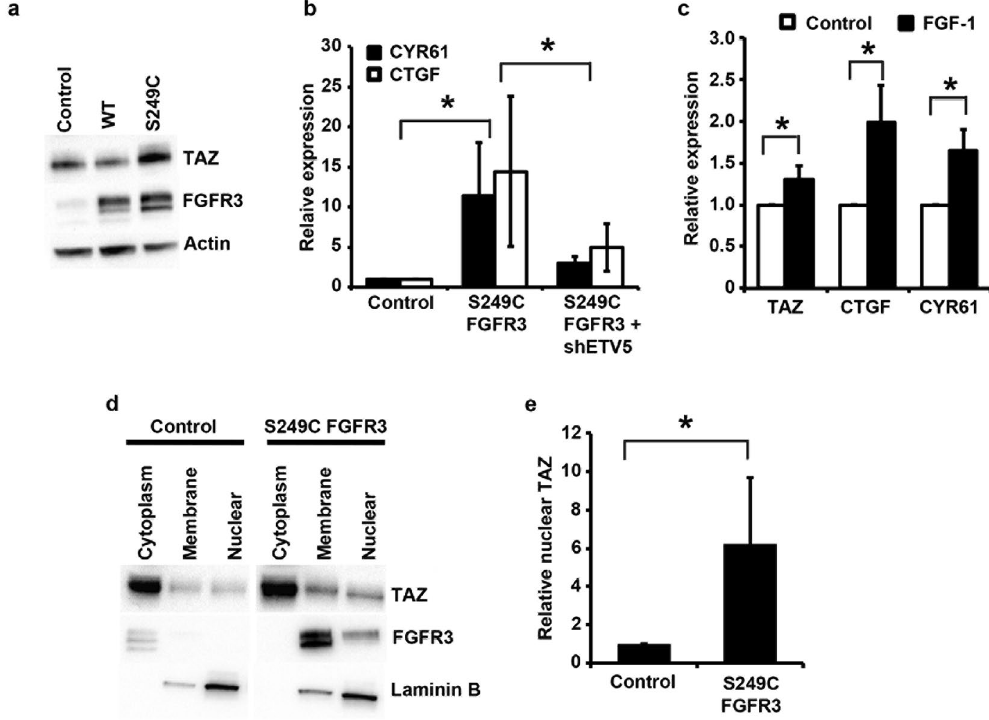
Figure 5. TAZ activity is altered in urothelial cells after FGFR3 or ETV5 modulation. ( a ) TAZ and FGFR3 protein expression in confluent TERT-NHUC cells overexpressing wildtype (WT) and S249C FGFR3, and in cells transduced with the empty vector (control); ( b ) CTGF and CYR61 levels in confluent TERT-NHUC expressing the S249C FGFR3 mutation (S249C), cells expressing the S249C FGFR3 mutation but with ETV5 knockdown (S249C shETV5), and cells transduced with the empty vector (Control); ( c ) TAZ, CTGF and CYR61 mRNA expression in sub-confluent TERT-NHUC overexpressing wild type FGFR3 five hours after stimulation with FGF1, compared to unstimulated control cells; ( d ) Representative blot showing TAZ protein levels in cytoplasmic, membrane and nuclear sub-fractions of confluent TERT-NHUC cells overexpressing S249C FGFR3 and control cells transduced with the empty vector; ( e ) Quantification of TAZ nuclear protein levels in confluent TERT-NHUC overexpressing S249C FGFR3 relative to control cells transduced with the empty vector. Values were adjusted for overall TAZ expression (calculated as the sum of expression in the different cellular fractions), to account for the higher overall expression in FGFR3 mutant cells. mRNA expression levels were relatively quantified using Taqman Real-Time RT-PCR with SDHA as internal control, while TAZ protein level was visualized by western blotting with a specific antibody, using actin or laminin B1 as loading or fractionation control. All experiments were repeated in triplicate. ‘ * ’ indicates a statistically significant difference between